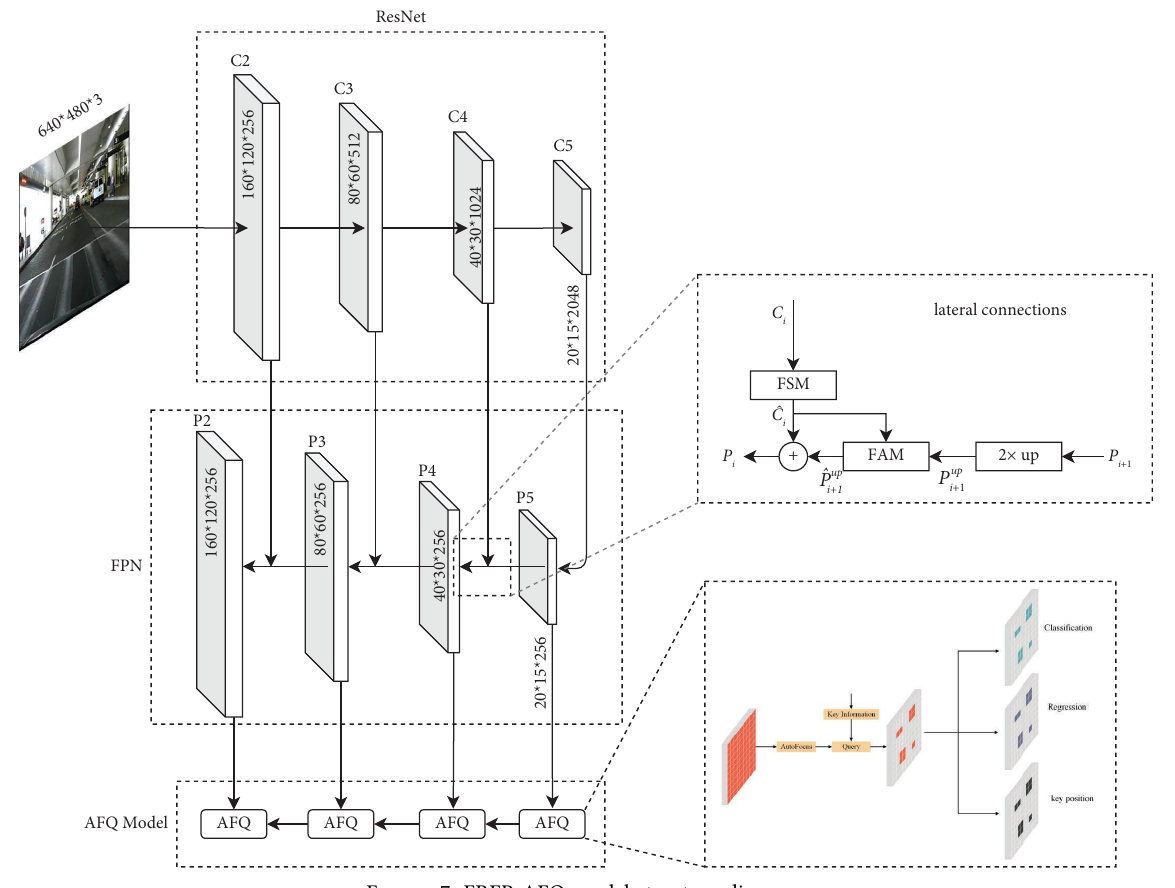
Figure 7: FRFP-AFQ model structure